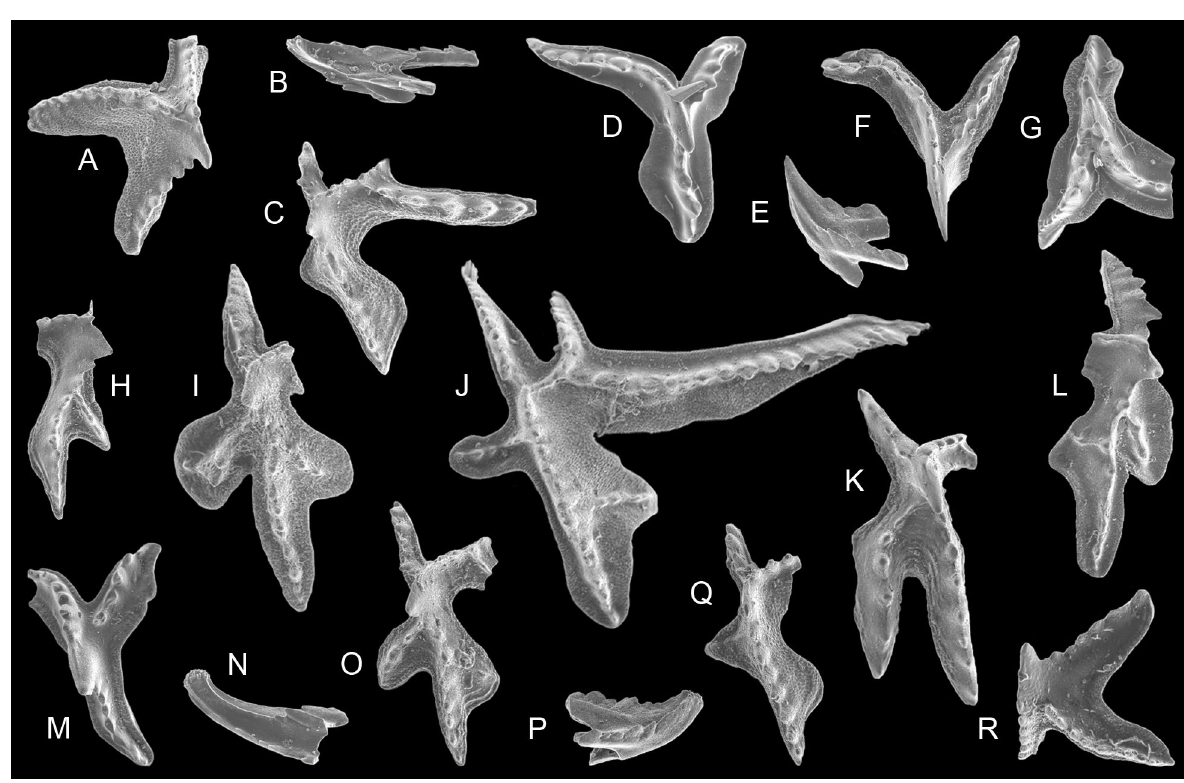
Fig. 6. A , Eoplacognathus foliaceus (F(cid:229)hr(cid:230)us, 1966), Pb element, LO11390t, × 74, sample Est09:OS3. B , Eoplacognathus S element, LO11391t, × 70, sample Est09:OS3. C , Eoplacognathus foliaceus (F(cid:229)hr(cid:230)us, 1966), Pa element, LO11392t, × 92, sample